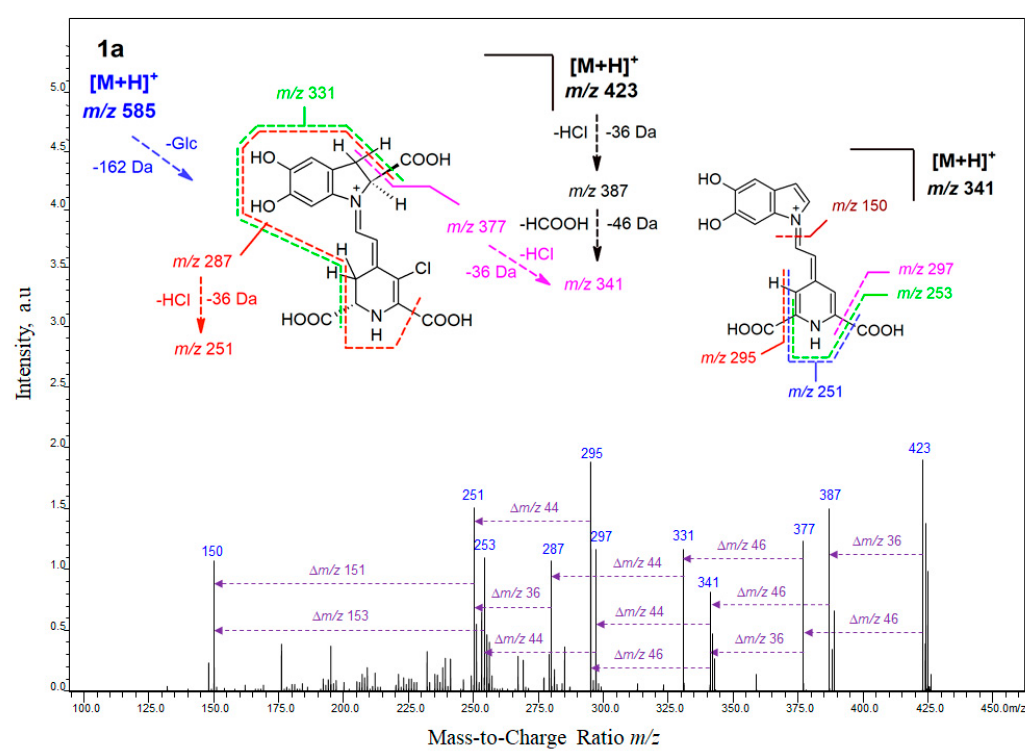
Figure 3. The HRMS fragmentation spectrum obtained by IT-TOF for chlorinated betanin 1a and chlorinated decarboxylated derivatives 2a and 6a as well as fragmentation pathways for their deglucosylated protonated ions.